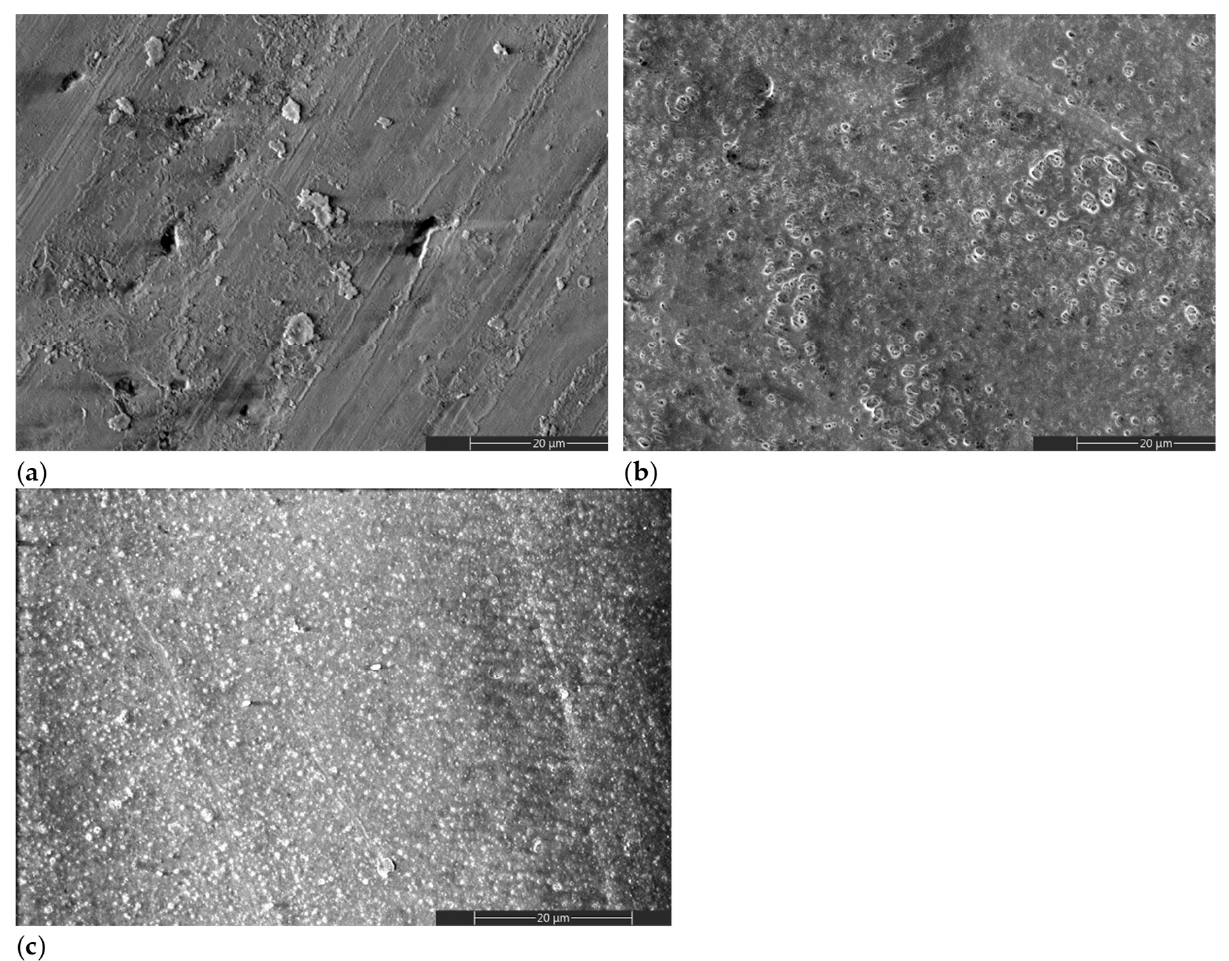
Figure 2. SEM images of ( a ) HAP_i; ( b ) HAP_g; ( c )